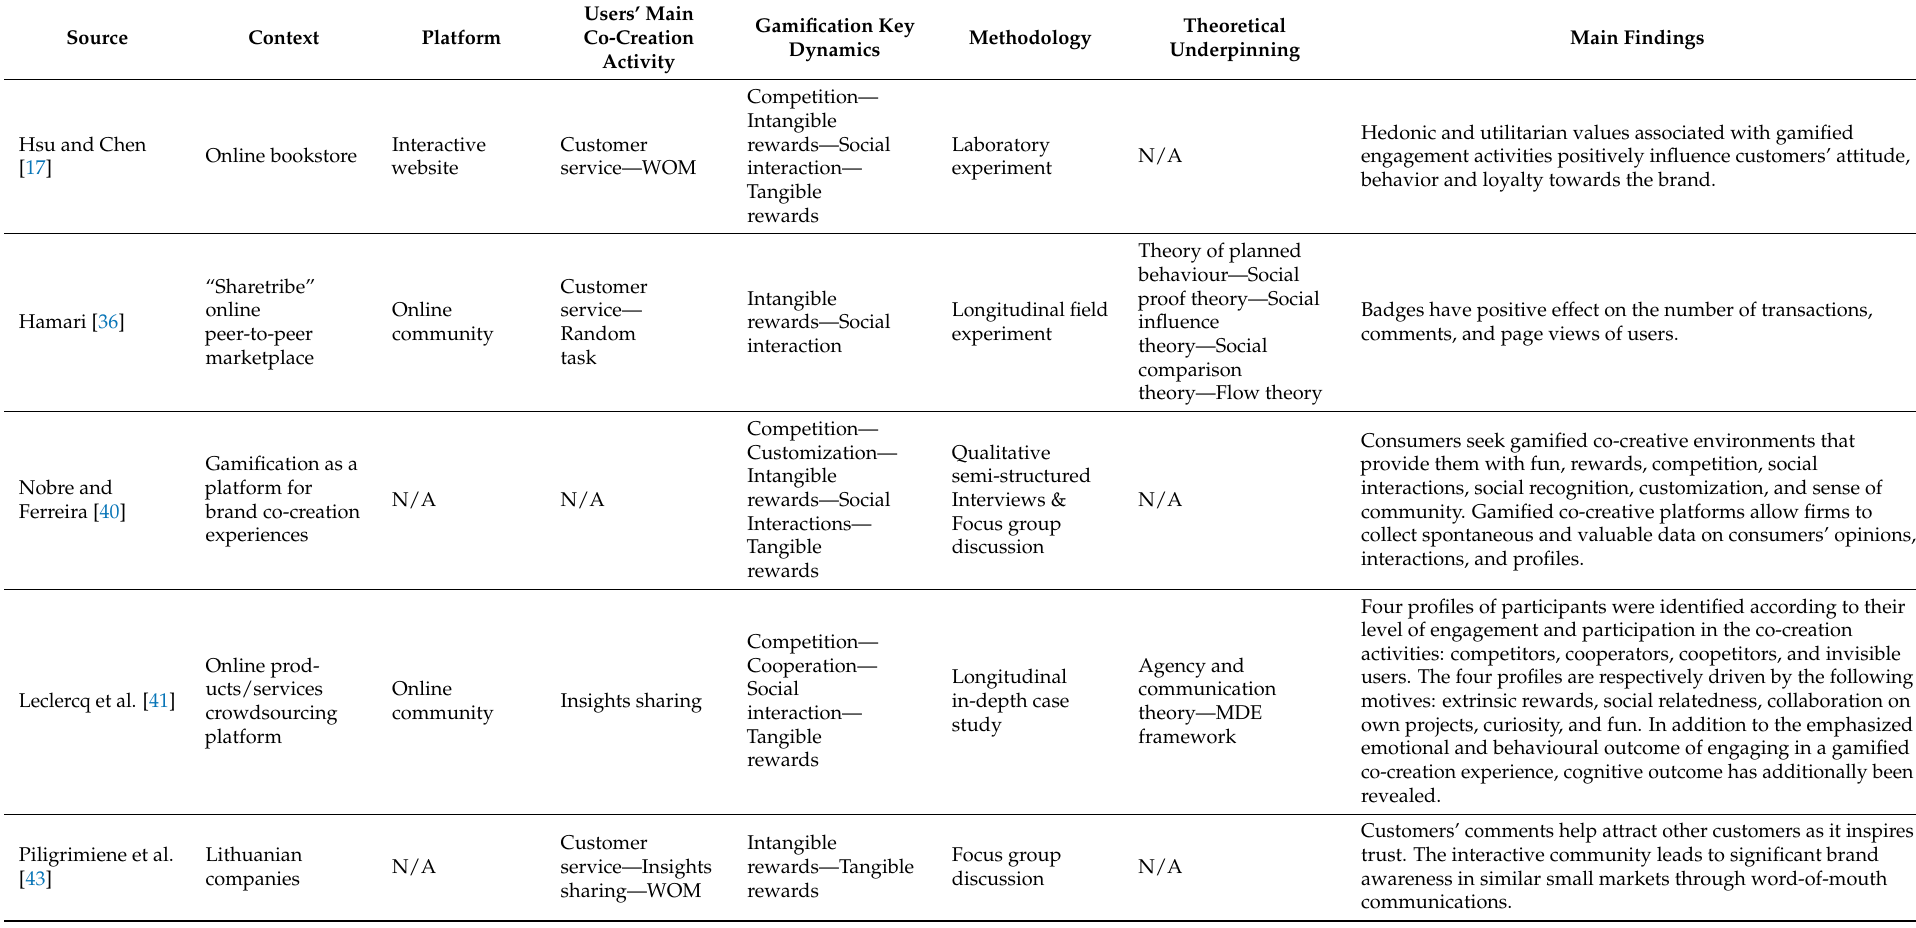
Table 1. Key findings of the surveyed case